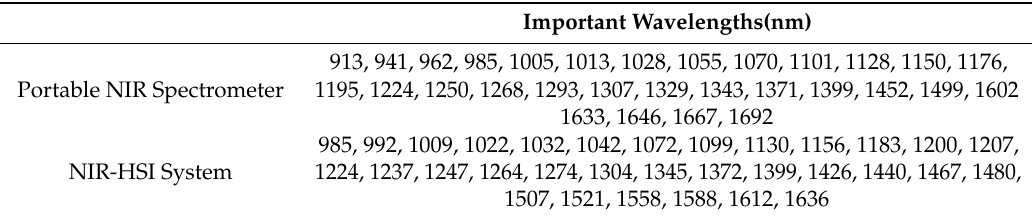
Table 3. The important wavelengths recognized by